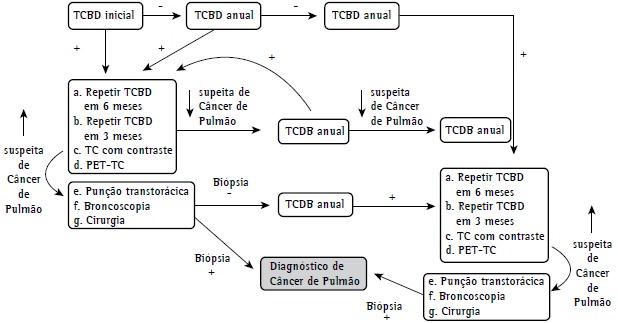
Fluxograma das possibilidades de acompanhamento. TCBD: TC de baixa
dosagem; e PET-TC: positron emission tomography-TC (tomografia por emissão
de pósitrons combinada com TC).